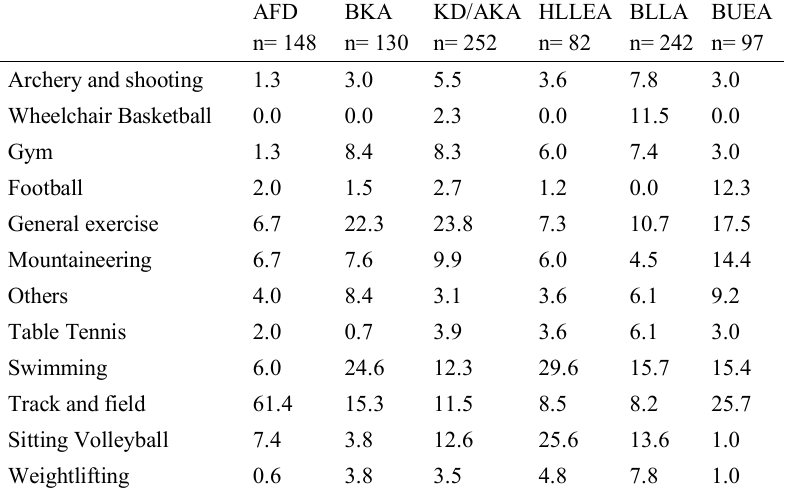
Table 4. Types of sports participated by veterans * (